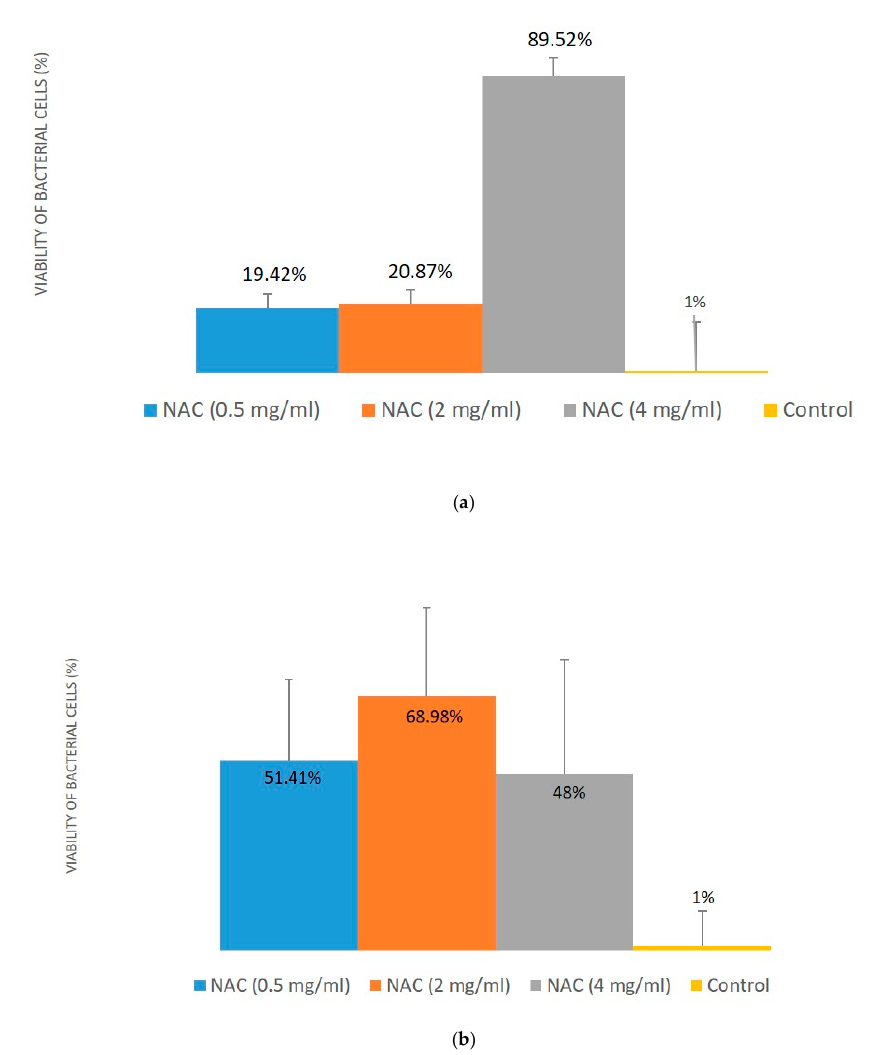
Figure 6. Percentage of biofilm reduction, expressed as a means ± SDs, of ( a ) free N-acetylcysteine, at 0.5, 2, 4 mg·mL − 1 ; control; ( b ) NACESOL TM , at 0.5, 2, and 4 mg·mL − 1 of active; control.